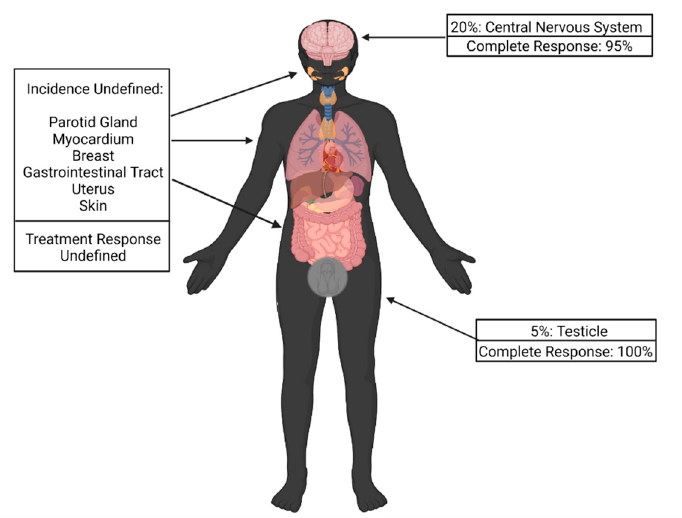
Figure 1. Incidence of extramedullary disease relapse by site and response to chimeric antigen receptor T-cell therapy.